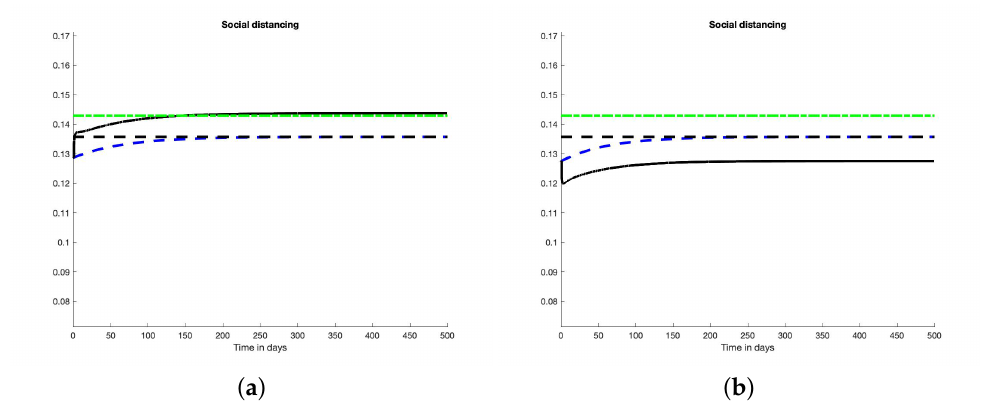
Figure 3. Scenario 2: Control. ( a ) 0.95 γ model : β , β ∗ (- -,blue), γ (- ., green) and β acceptable (- -, black);